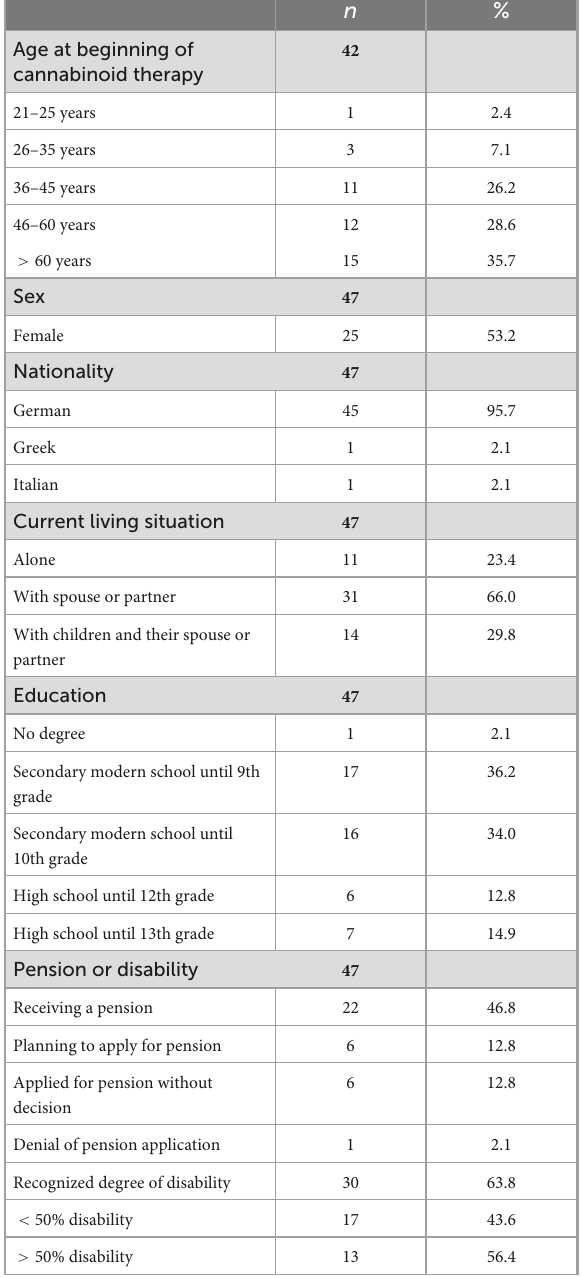
TABLE 1 Sociodemographic data of